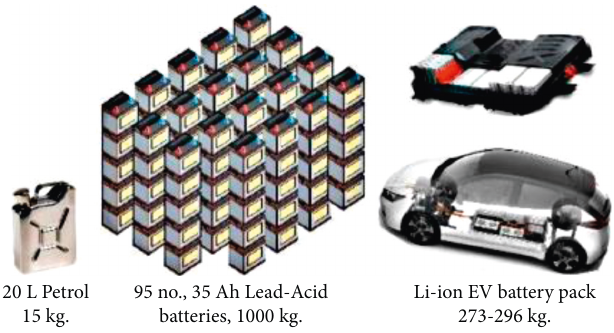
Figure 10: Size comparison of three systems for a travel range of 250km. Table 1: EV batteries in different EVs.